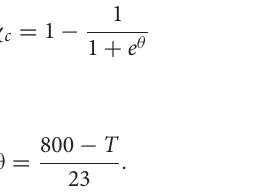
Frontiers in Earth Science |